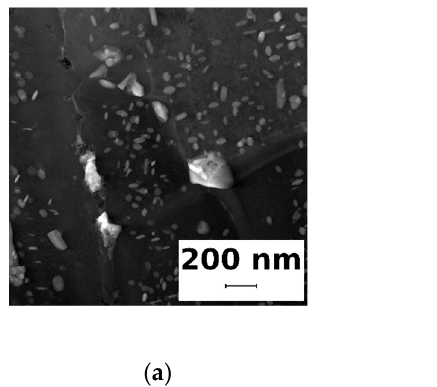
Figure 6. Pole figures of SPSed ( a ) and SPS-KOBO extruded ( b ) AA7075.